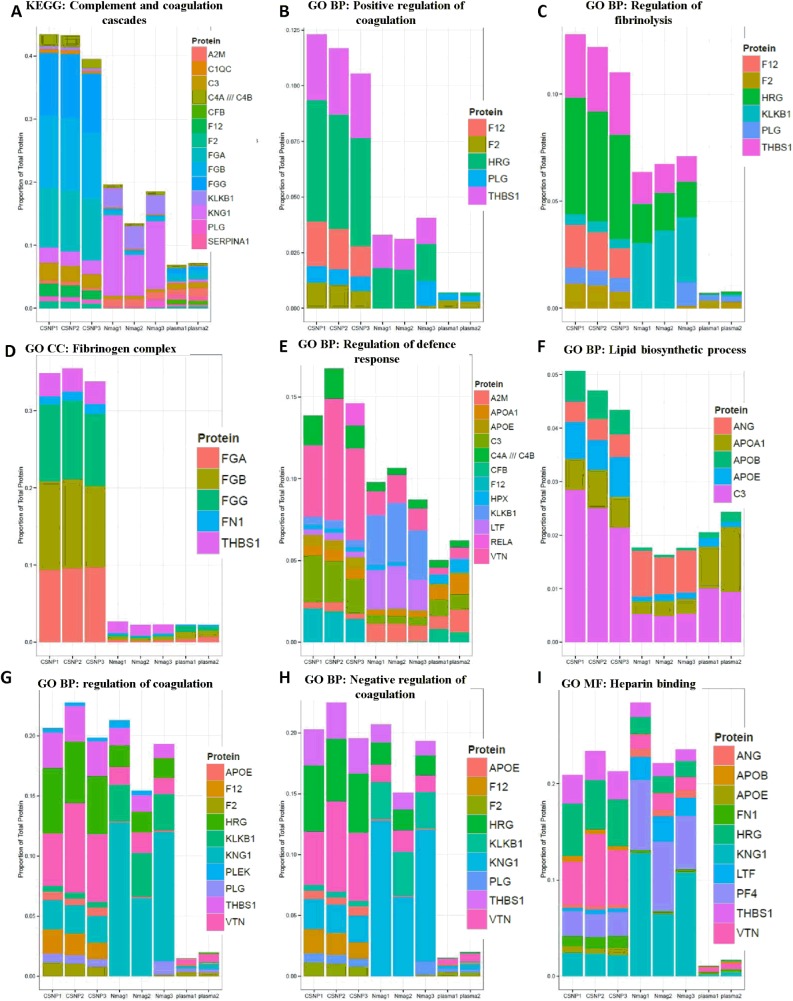
Plasma protein corona composition on CSNP.Classification of identified corona proteins according to differentially enriched Gene Ontology (GO) categories and KEGG pathways. The relative abundances of the proteins, as a percentage of total estimated protein abundance in the sample, are shown and each replicate is plotted separately. A significant enrichment of plasma proteins absorbed on the CSNP surface involved (A) KEGG Complement and coagulation cascades pathway, (B) GO Regulation of coagulation, (C) GO Negative regulation of coagulation, (D) GO Positive regulation of coagulation, (E) GO Regulation of fibrinolysis, (F) GO Fibrinogen complex, (G) GO Heparin binding, (H) GO Regulation of defense response, and (I) GO Lipid biosynthetic process. For further details, refer to S3, S5 and S6 Tables.